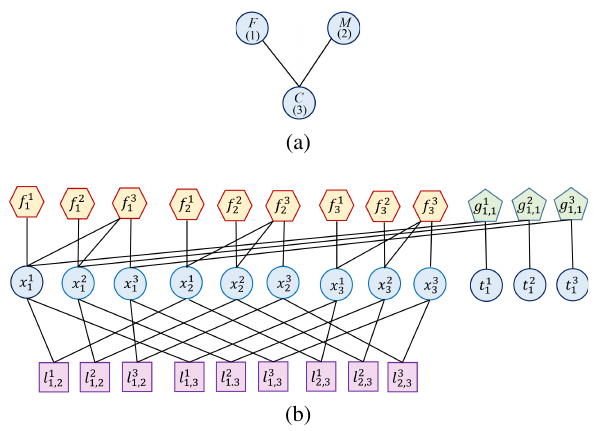
Fig. 1 Factor graph representation of a family with three members M , F , and C with 3 SNPs and 1 trait each individual. (a) Familial relationship. (b) A factor graph integrates all variables and data